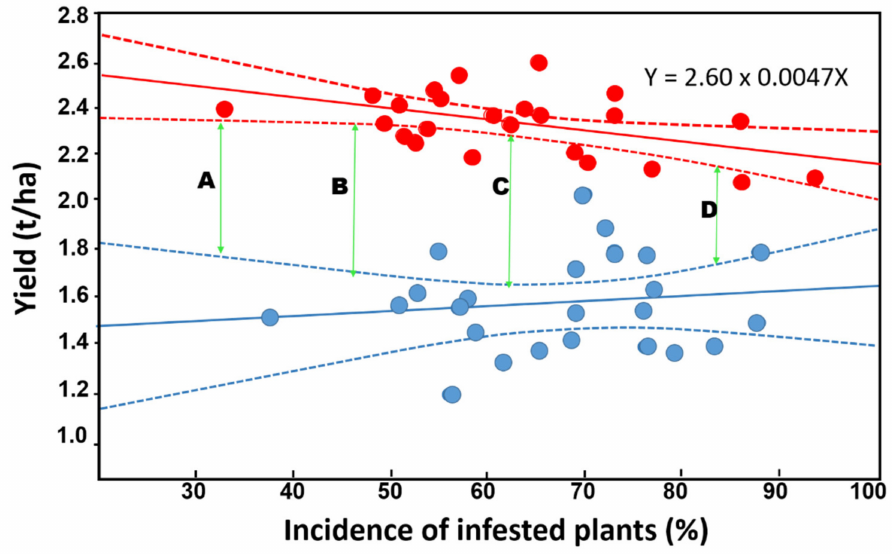
Figure 4. Regression lines indicating the relationships between incidence of plants with FAW damage to whorl leaves and yield in trial 4. Red lines = sprayed plots; black lines = unsprayed plots. Dotted lines represent 95% confidence intervals. Green arrows (A–D) indicate varying distances between the confidence interval